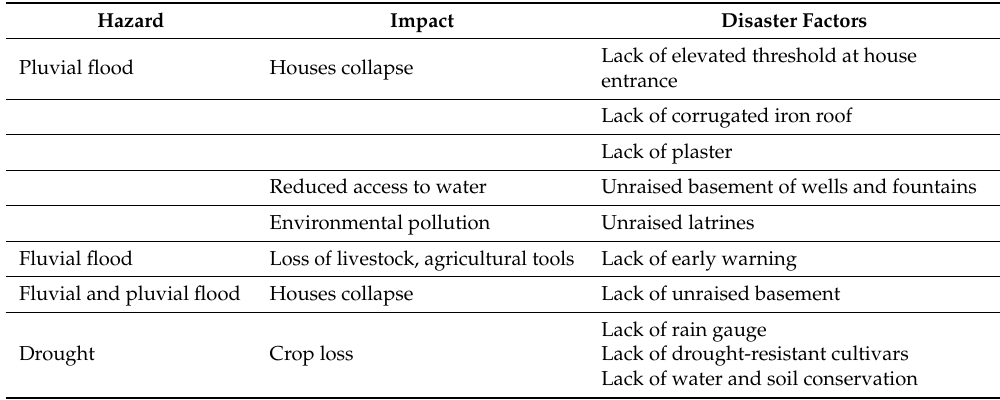
Table 3. Factors contributing to disastrous floods and drought as ascertained in Falmey, Gu é chem é , Ki é ch é , Tessa, and Tounouga municipalities in July 2018.